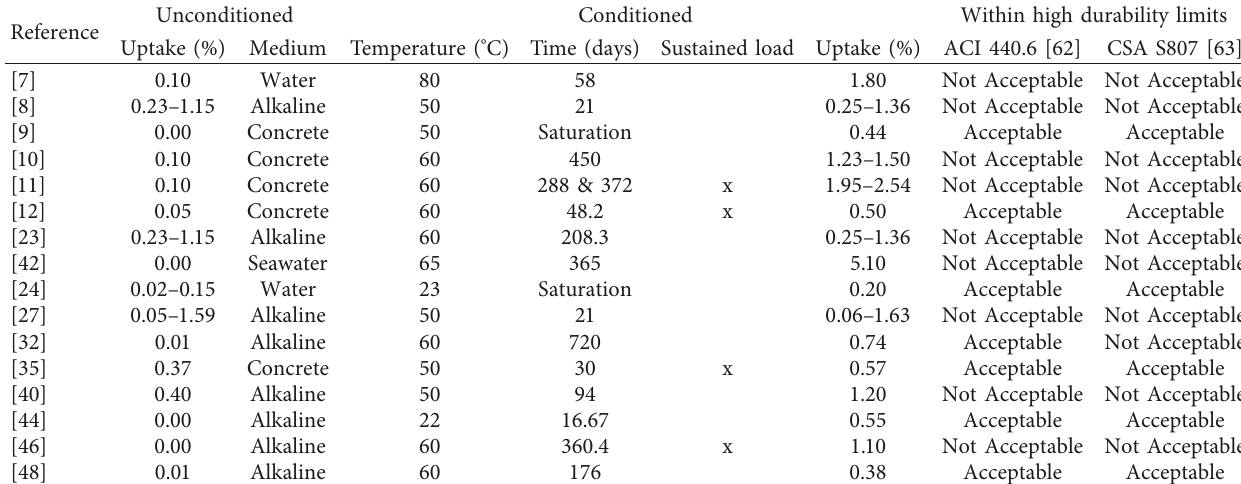
Table 8: Results of moisture uptake of GFRP reinforcing